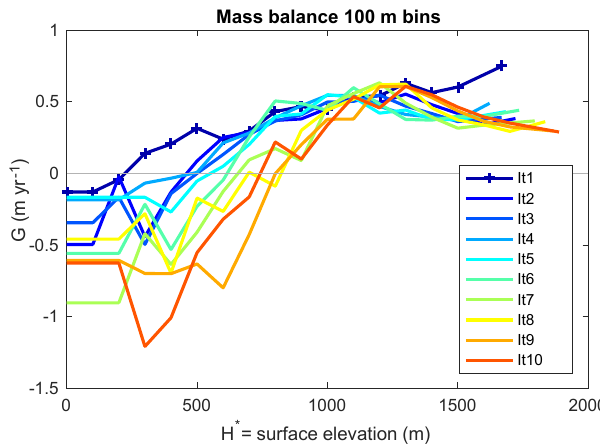
Figure 3. Characterizing annual mass balance vs. surface elevation. The domain is sorted into 100m bins, and within each bin the mass balance is averaged. Elevations falling within the range of the bin have the associated mass